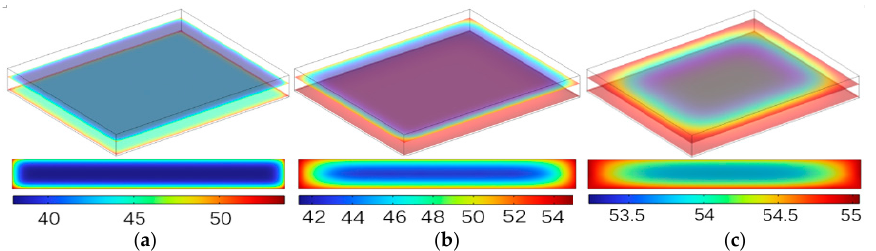
Figure 9. The temperature distribution. (The values in the figure represent temperature, unit: °C) ( a ) The temperature distribution of tobacco strips at 1 s; ( b ) the temperature distribution of tobacco strips at 25 s; ( c ) the temperature distribution of tobacco strips at 50 s.